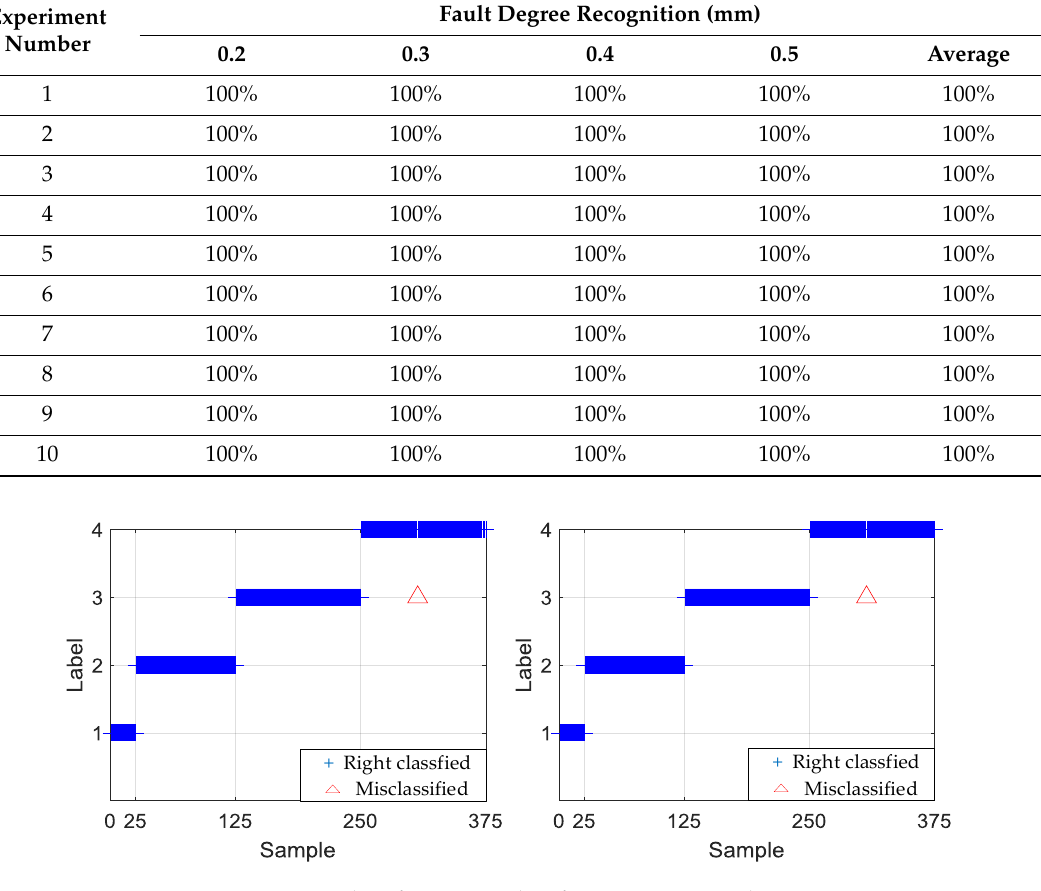
Figure 7. Physical pictures of fault bearing.